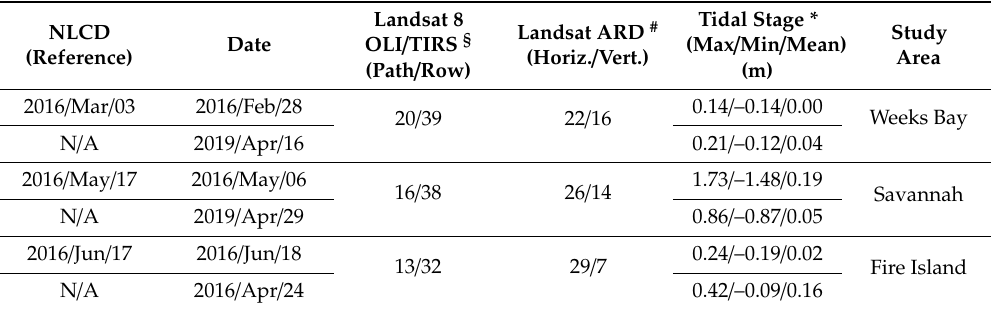
Table 1. Imagery dataset used in land cover classification of the 2016 National Land Cover Database (NLCD) (reference) and the dataset used for image segmentation, feature extraction, training and validation, and updating emergent herbaceous wetland